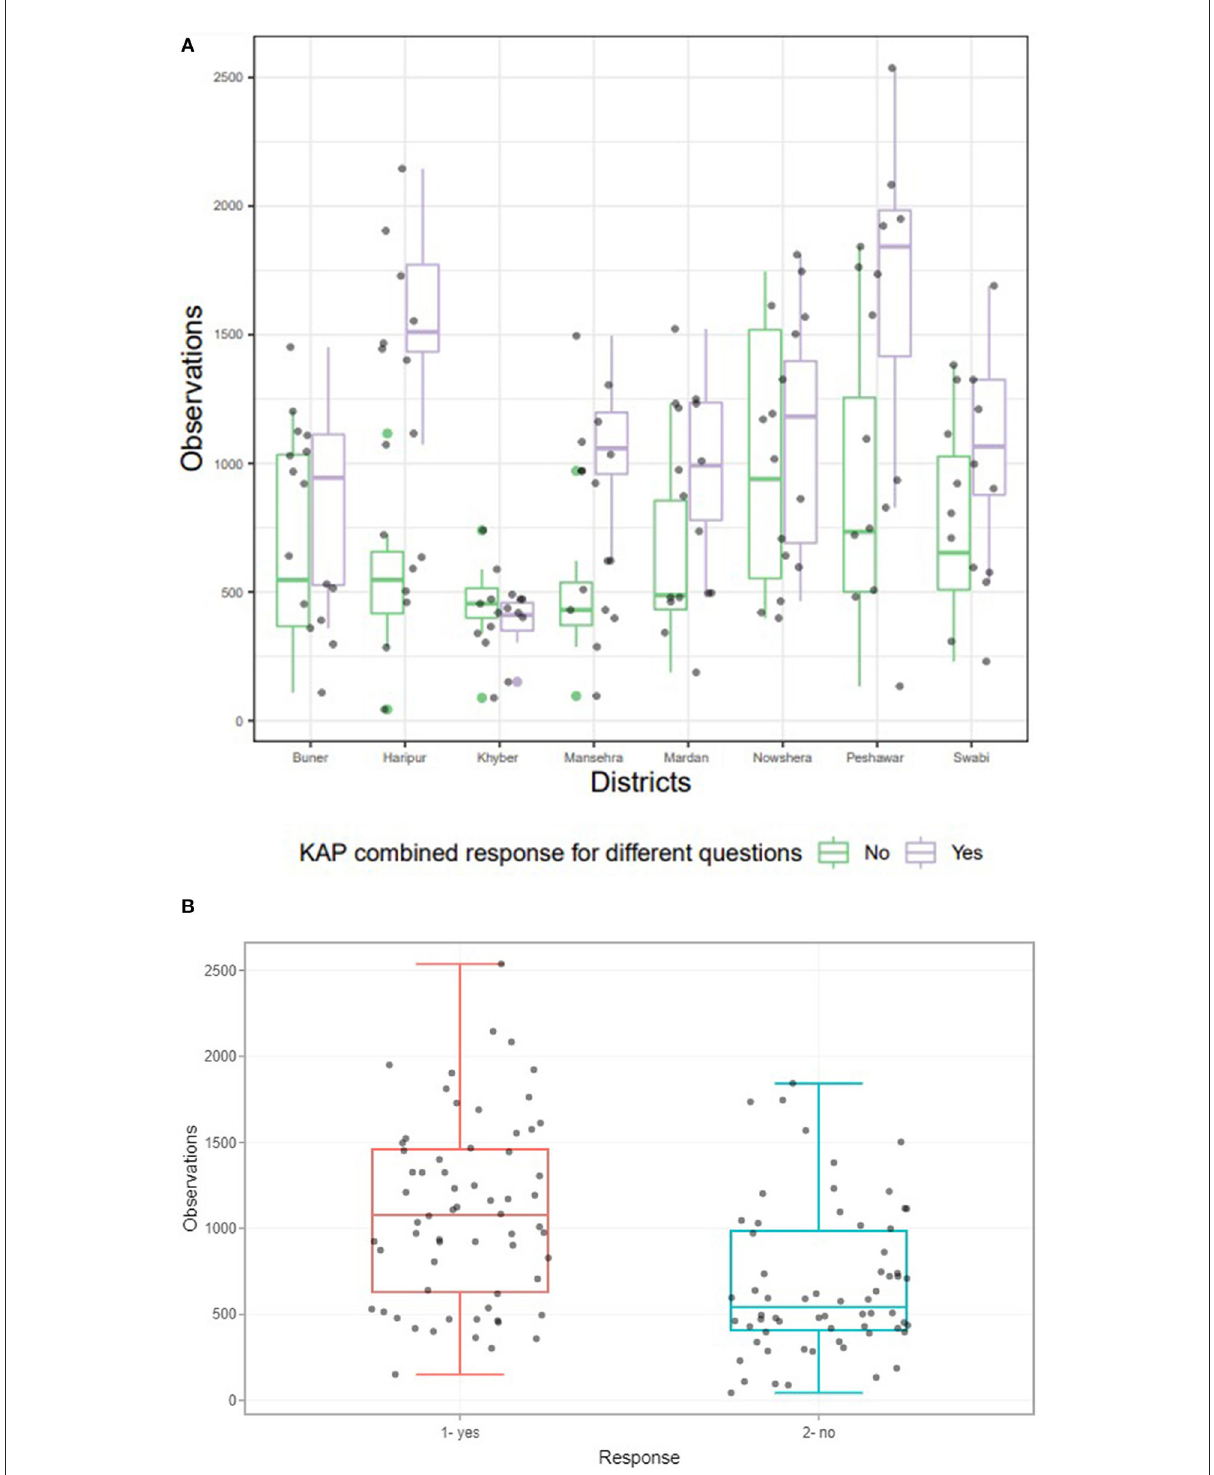
FIGURE6 (A) District wise response of communities for questions mentioned in Supplementary Table 1. The above boxplot revealed significant relationship between the response of KAP for different questions for eight districts considered for study ( p < 0.05). (B) Collective response of communities in the form of Yes and No for all districts to our questionnaires (Supplementary Table 1). Boxplot revealed significant association between collective responses of KAP questionnaire for different questions asked from eight districts considered for study. P -value was statistically significant at 5% level of significance, which was based on Chi Square test of